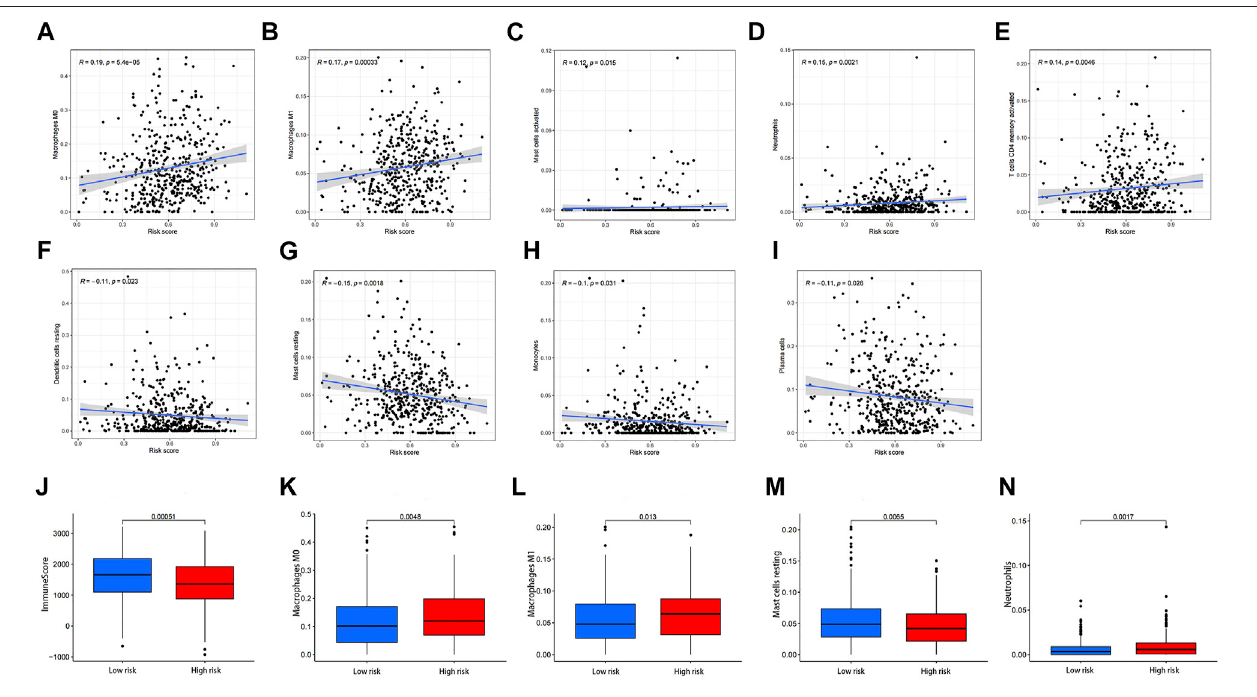
FIGURE 11 | Correlation analysis of risk score and immune cells. (A) M0 macrophages, (B) M1 macrophages, (C) activated mast cells, (D) neutrophils, (E) activated memory CD4 T cells, (F) resting dendritic cells, (G) resting mast cells, (H) monocytes, and (I) plasma cells. (J) The difference of immuneScore, (K) M0 macrophages, (L) M1 macrophages, (M) resting mast cells (N) neutrophils between high- and low-risk